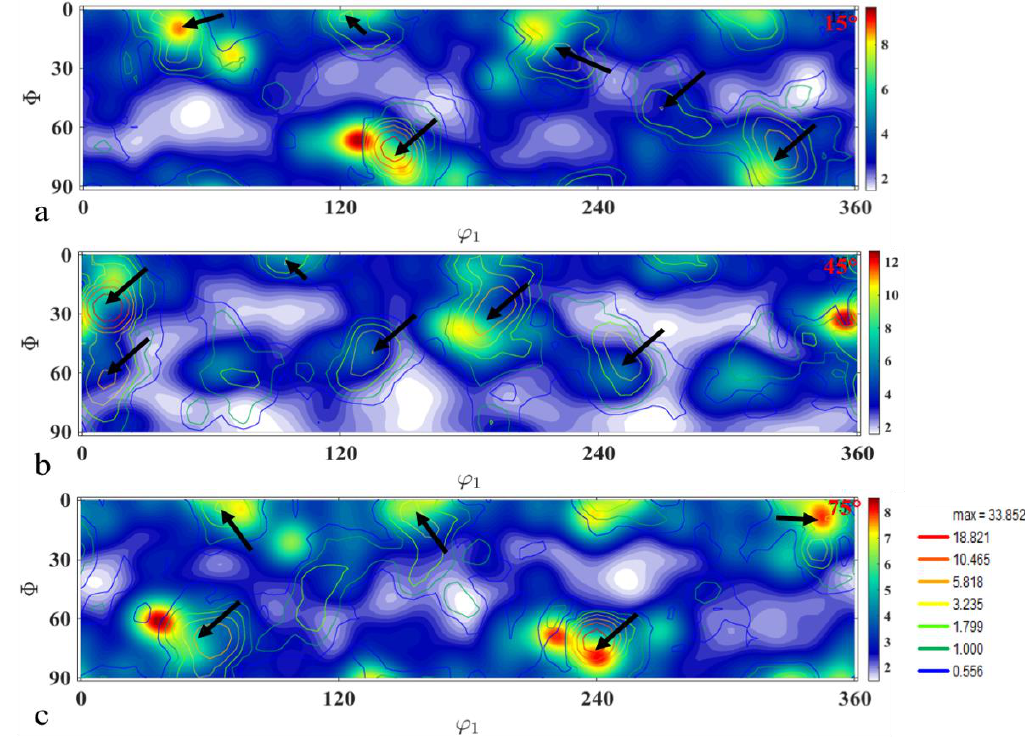
Figure 9. The overlapped VODF (contour map with arrows indicating dominant components) and UODF (color gradient map) of the material at two different deformation levels (UODF at 5% and VODF at ≥74%); (a) 𝜑 2 = 15°, (b) 𝜑 2 = 45°, (c) 𝜑 2 = 75°.